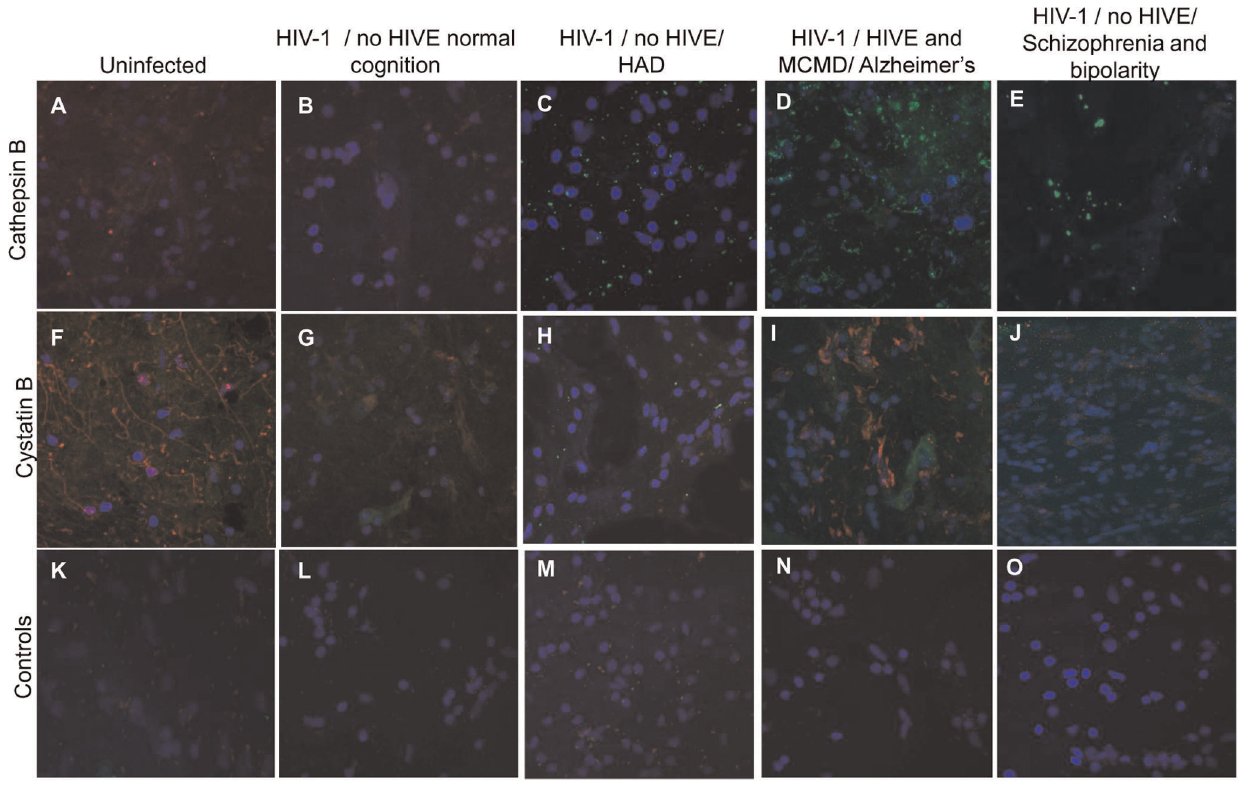
Figure 8. Expression of cathepsin B and cystatin B in the hippocampus of post-mortem brain tissues. Hippocampal tissue from HIV- seronegative (A, F and K) and HIV-seropositive (B-E, G-J and L-O) patients were stained with mouse anti-human cathepsin B followed by Alexa 488 conjugate goat anti-mouse (green), or mouse anti-human cystatin B followed by Alexa 488 conjugate goat anti-mouse (green), and rabbit anti- human Iba-1 followed by Alexa 546 goat anti-rabbit (red), and nuclear staining by DAPI (blue). Hippocampus samples from the same patients stained only with secondary antibodies and DAPI were used as negative controls illustrated in K-O. For each color, detector gains were maintained standard in every caption taken with the Pascal software in a Zeiss LSM 5 confocal laser-scanning microscope using a 63 6